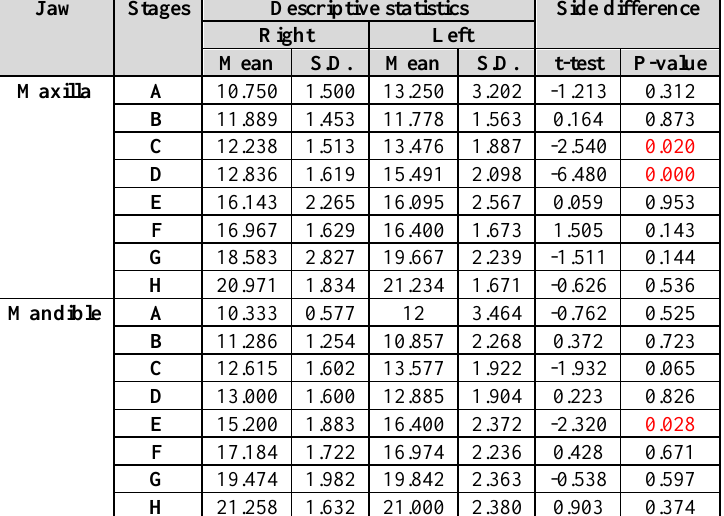
Table 5: Descriptive statistics and side difference of the age (in years) for each developmental stages of maxillary